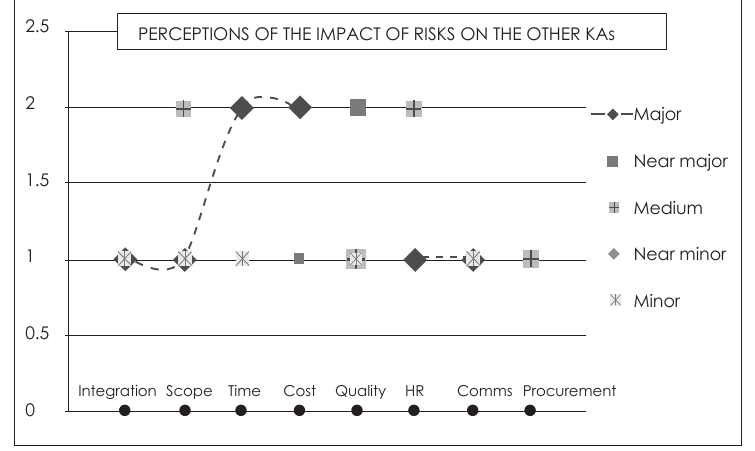
Figure 4: Case 2 – summarised perceptions of the impact of risks on the other KAs throughout the PLC